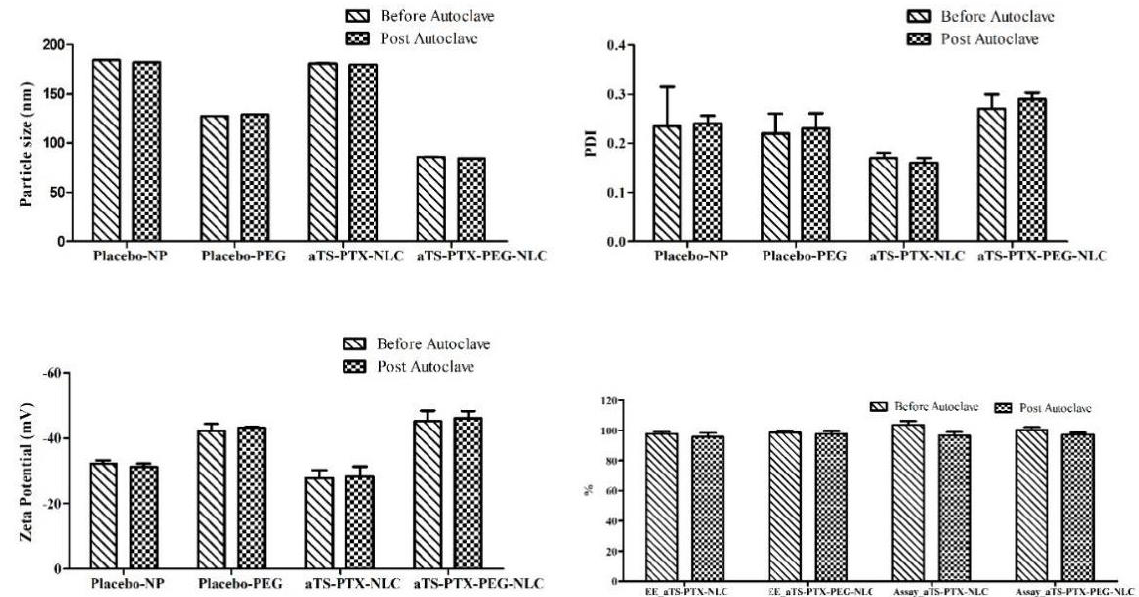
Figure 7. Comparison of the physical and chemical characteristics of the placebo and αTS -PTX-NLC formulation before and after autoclave.